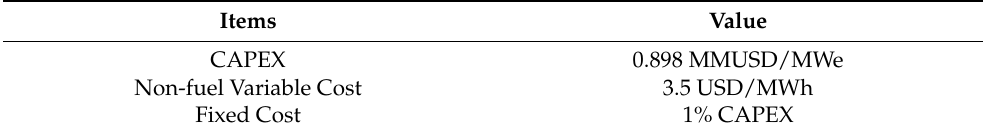
Table 12. The cost structure for gas combined cycle